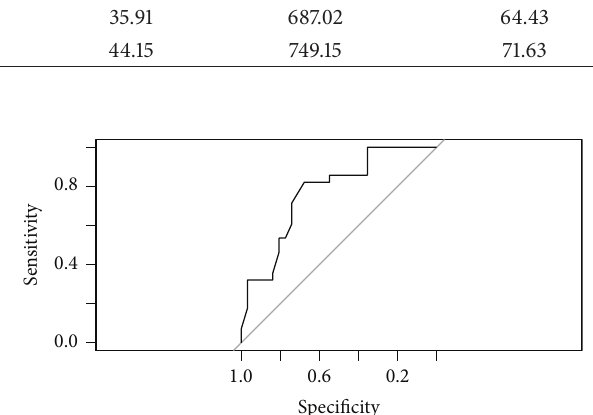
Figure 2: ROC curve for model MOD-A1.